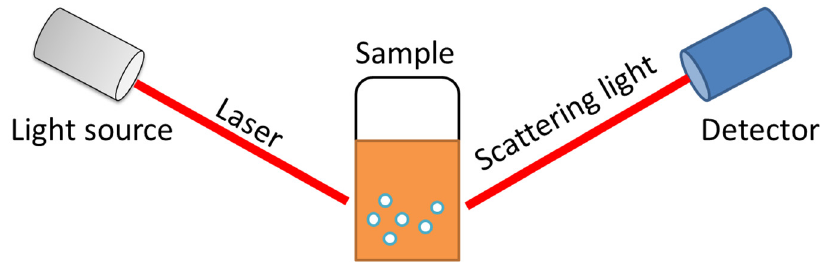
Figure 2. Block diagram of ex-situ DLS configuration.